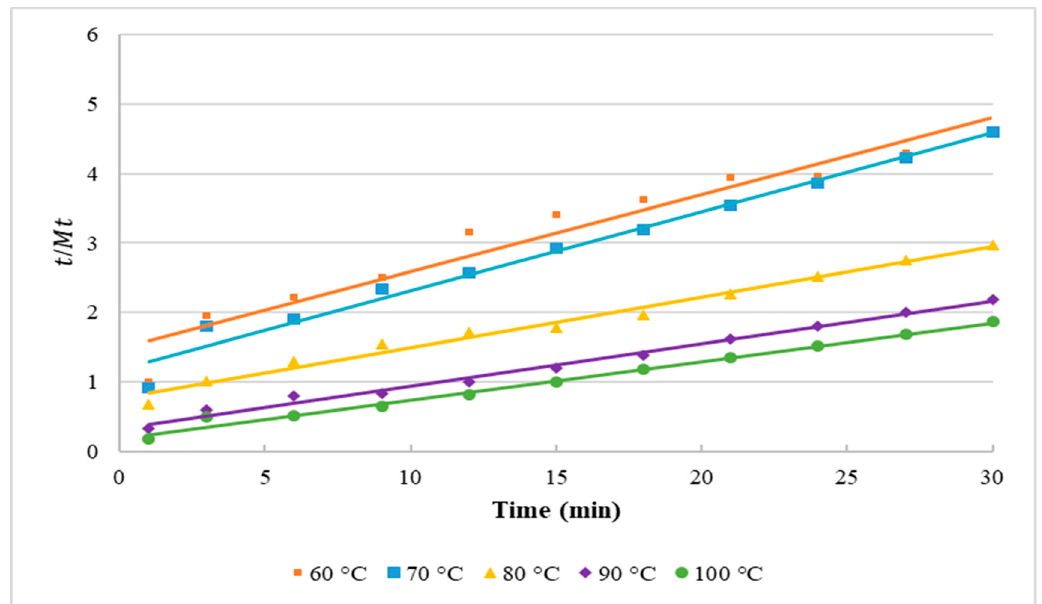
Figure 1. Second-order Rate Law kinetic model of Nannochloropsis sp. microalgal lipids using MAE-brine at different extraction temperatures. Table 3. The extraction coefficient, yield at saturation, and statistical parameters for lipid extraction from Nannochloropsis sp. microalgae using MAE-brine according to the second-order Rate Law model. Extraction Temperature ◦